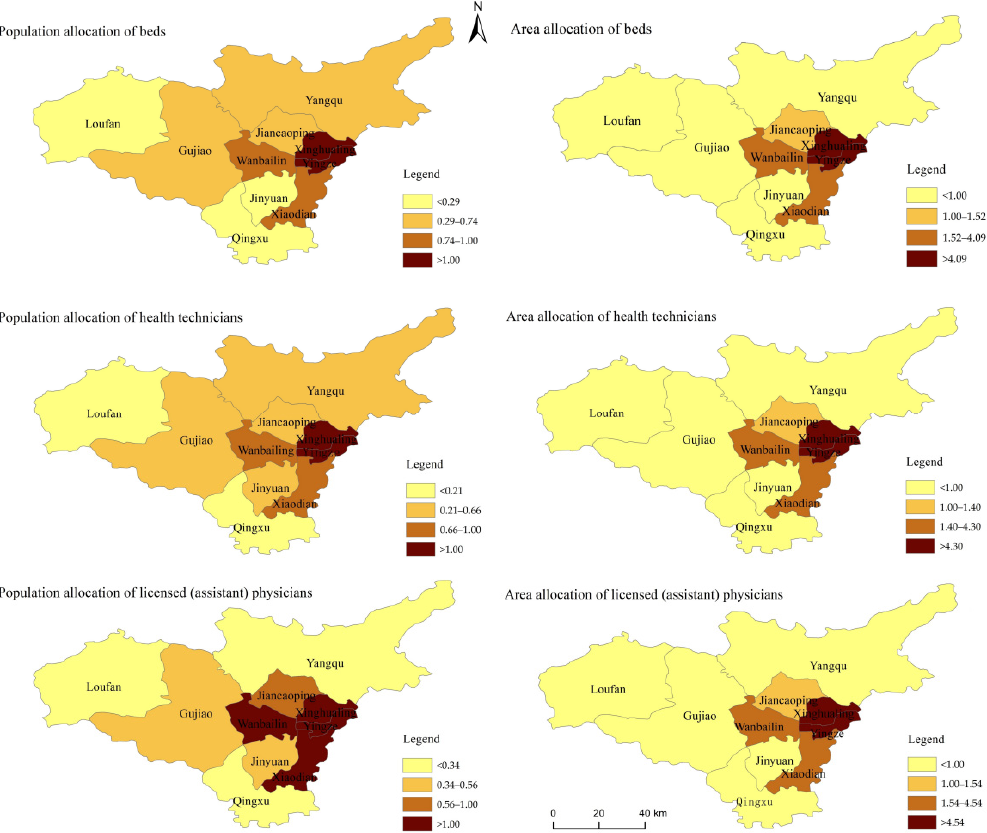
Figure 1. Agglomeration of medical and health resources in Taiyuan in 2019.